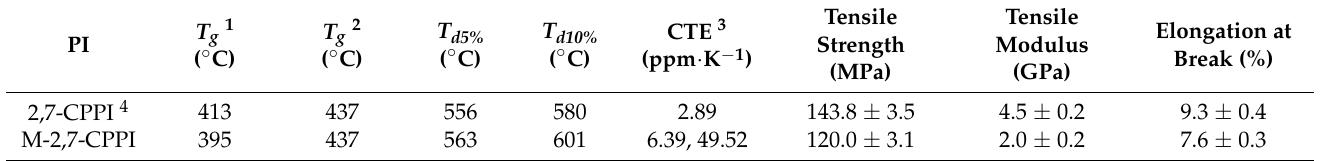
Table 1. Thermal and mechanical properties of M-2,7-CPPI and 2,7-CPPI.